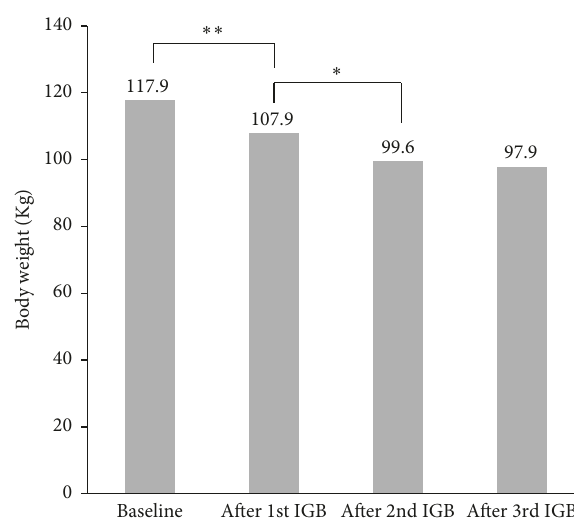
Figure1:IncrementalweightlossfollowingserialIGBtherapy( ∗ 𝑝 < 0.05 ; ∗∗ 𝑝 < 0.01